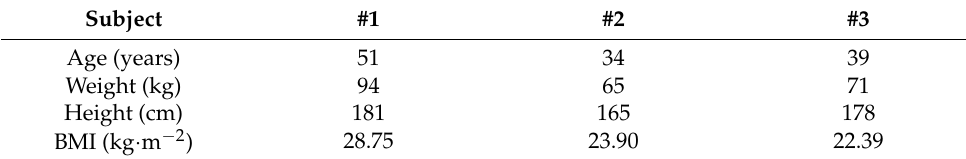
( C ) Figure 4. Molecule expression in monocytes analyzed at different monitoring points (T0 to T4), showing percentage of monocyte subsets before, during, and after testing. ( A ). CD14++CD16 − ( B ). CD14++CD16+ ( C ). Pro-inflammatory CD14LowCD16+. 3.3. Impact of Olive Oil Supplement on DC Maturation To evaluate olive oil supplement in DC maturation after intense physical exercise, mDCs and pDCs in the treated and non-treated subjects were identified at the different monitoring points. Mature DCs as a proportion of mDCs increased most rapidly from T3 and then declined towards T4 (Figure 5). Nevertheless, this decrease ( ∆ T3-T4/ ∆ T3-T2) measured in terms of the coefficient of variation (CV) was only significant for treated subjects (95% CI: 30–62%, p = 0.05) (Table 3). All mean values were analyzed in three repetitions of the analysis.